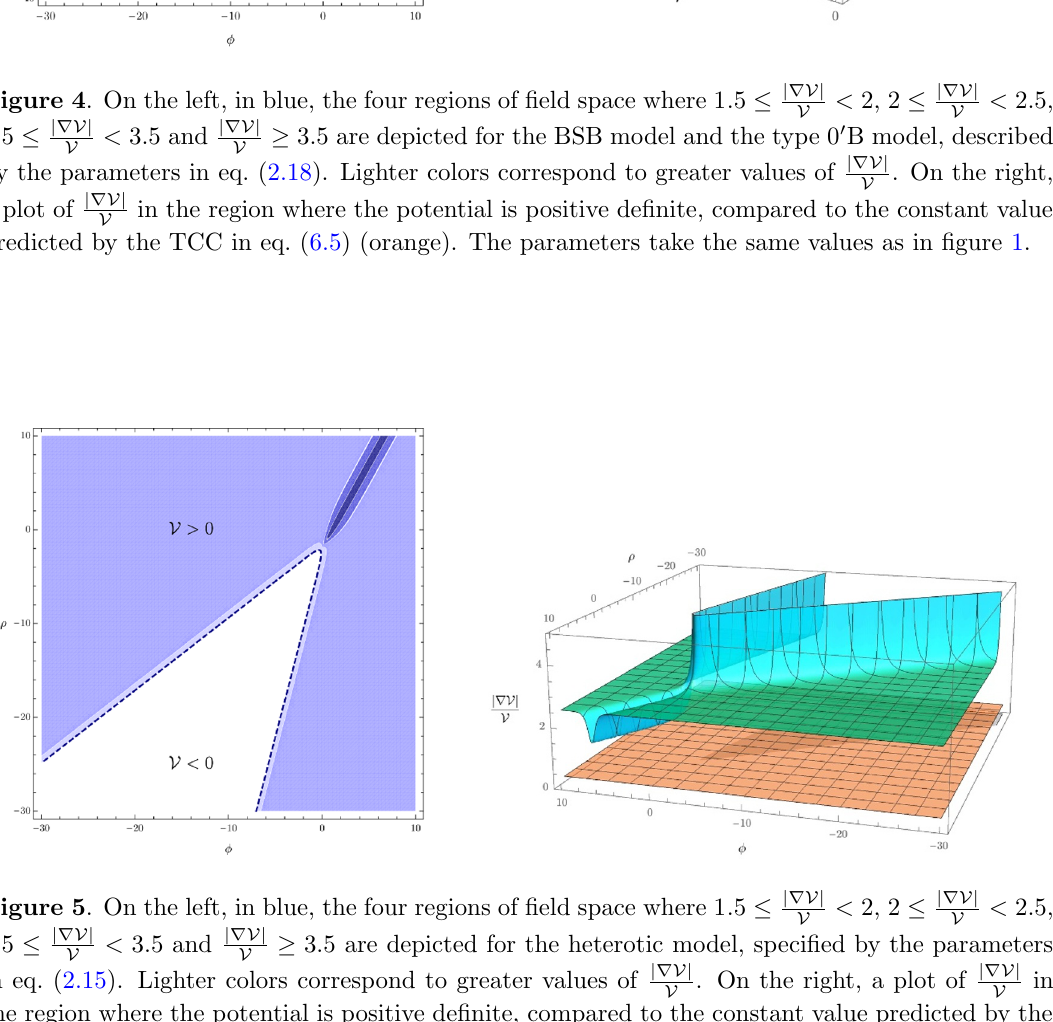
(cid:21) 3 : 5 are depicted for the heterotic model, speci(cid:12)ed by the parameters